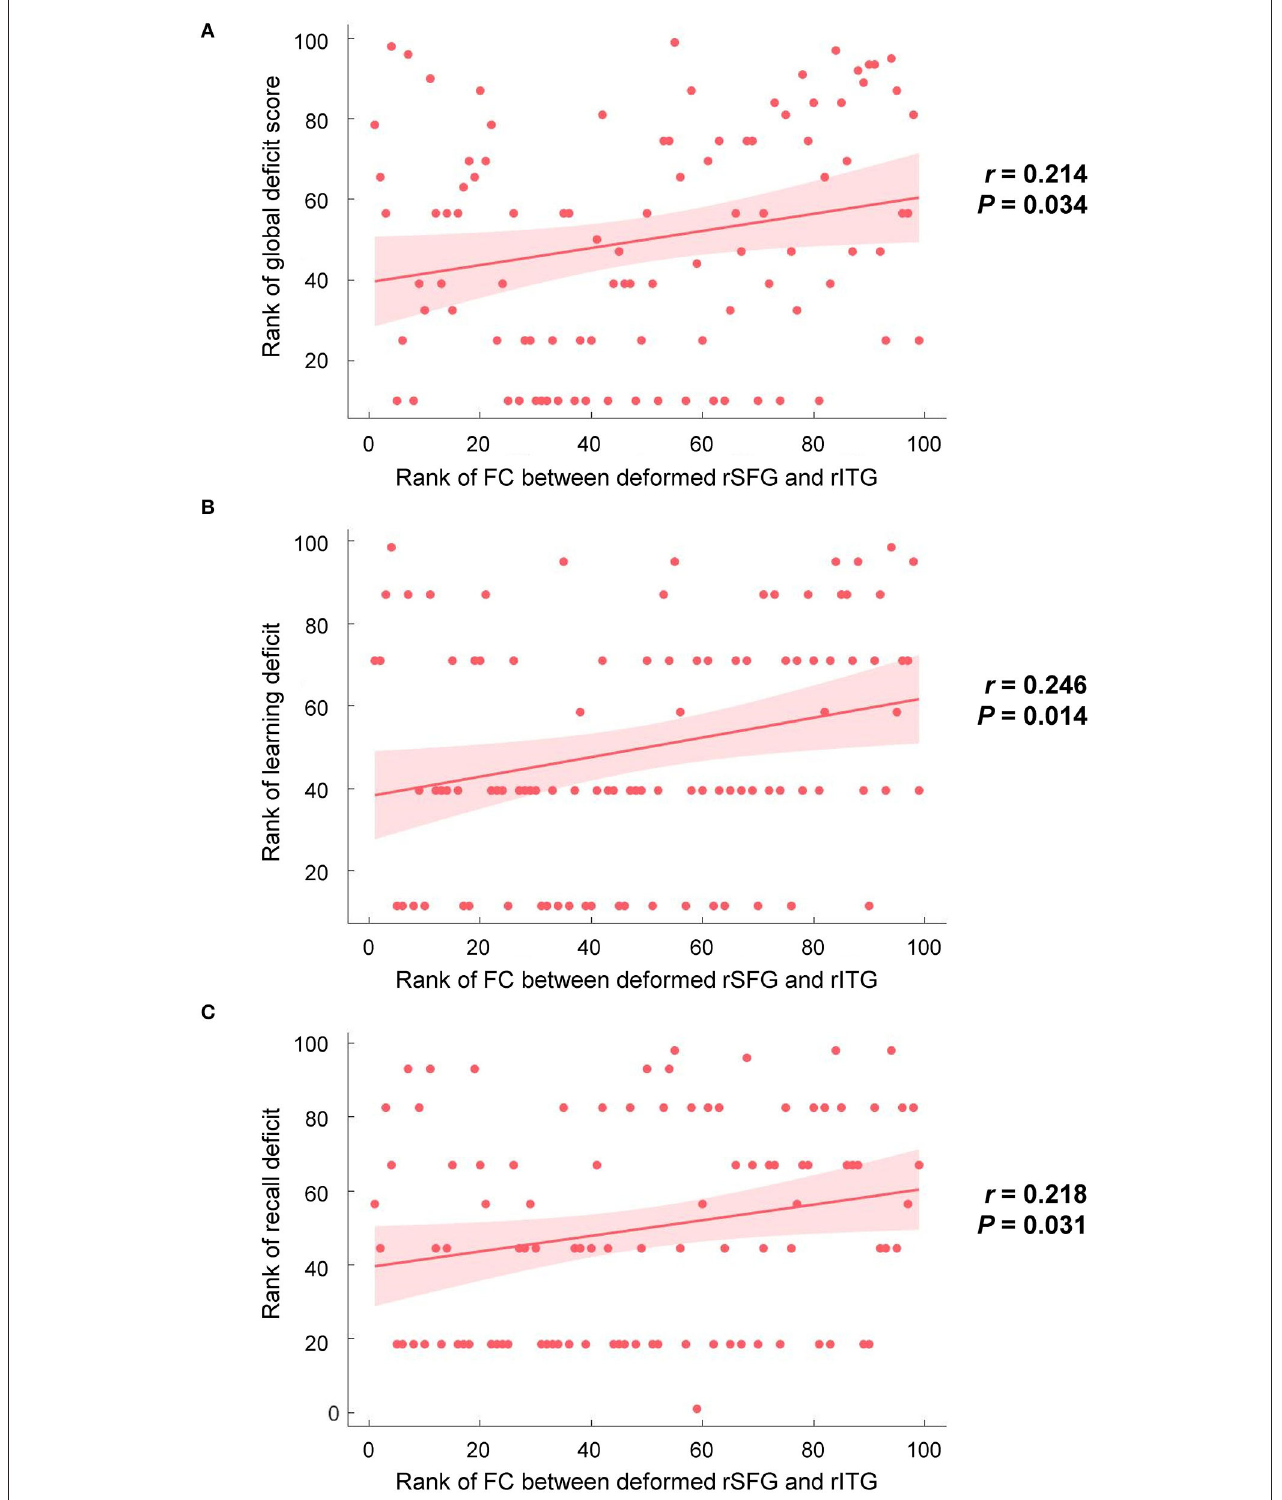
FIGURE 3 | Correlations between brain alterations and cognitive performances in the HIV + group. (A) The functional connection (FC) strength between the deformed right superior frontal gyrus (rSFG) and the right inferior temporal gyrus (rITG) was positively correlated with global deficit scores ( r = 0.214, P = 0.034). (B) The FC strength between the deformed rSFG and rITG was positively correlated with the deficit score of learning ( r = 0.246, P = 0.014). (C ) The FC strength between the deformed rSFG and rITG was positively correlated with the deficit score of recall ( r = 0.218, P = 0.031).